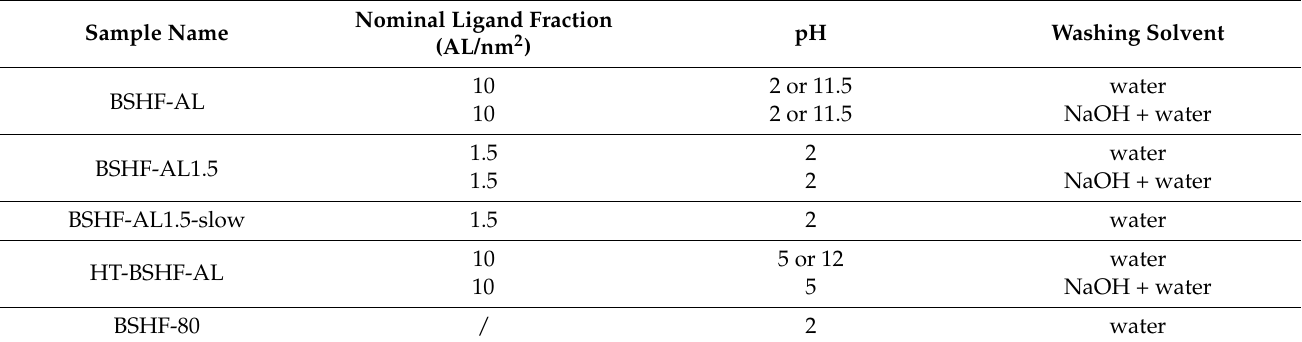
Table 2. Experimental conditions for coating the BSHF NPLs with